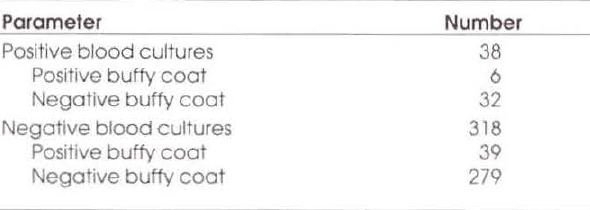
TABLE 1 Results of blood cultures and buffy coat smears Parameter Positive blood cultures Positive bufty coot Negative bufty coot Negative blood cultures Positive bufty coot Negative bufty